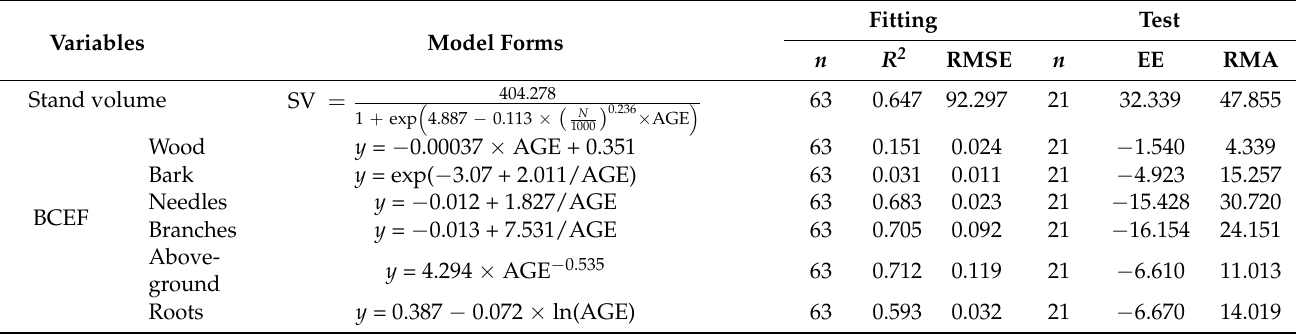
Table 5. The estimation result of the SV+BCEF. SV is the stand volume, N is the stand density, AGE is the stand age, y is the biomass conversion and expansion factors of each component (wood, bark, needles, branches), and above-ground and roots biomass conversion and expansion